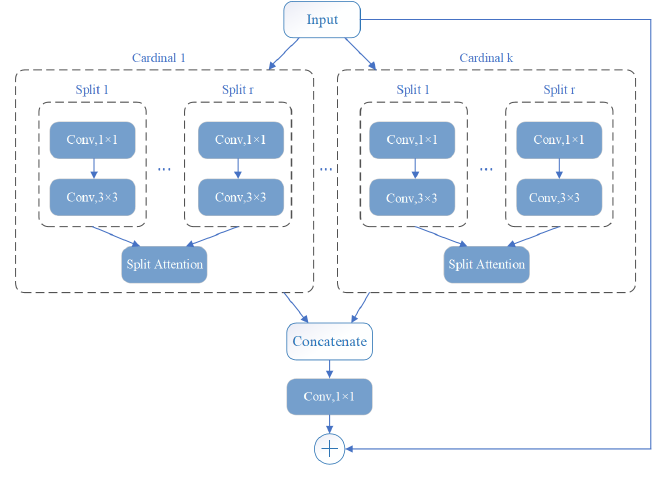
Figure 8. Network structure of ResNeSt